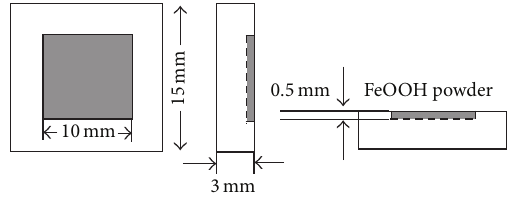
Figure 1: Test device for the study of iron corrosion in the presence of different types of FeOOH.